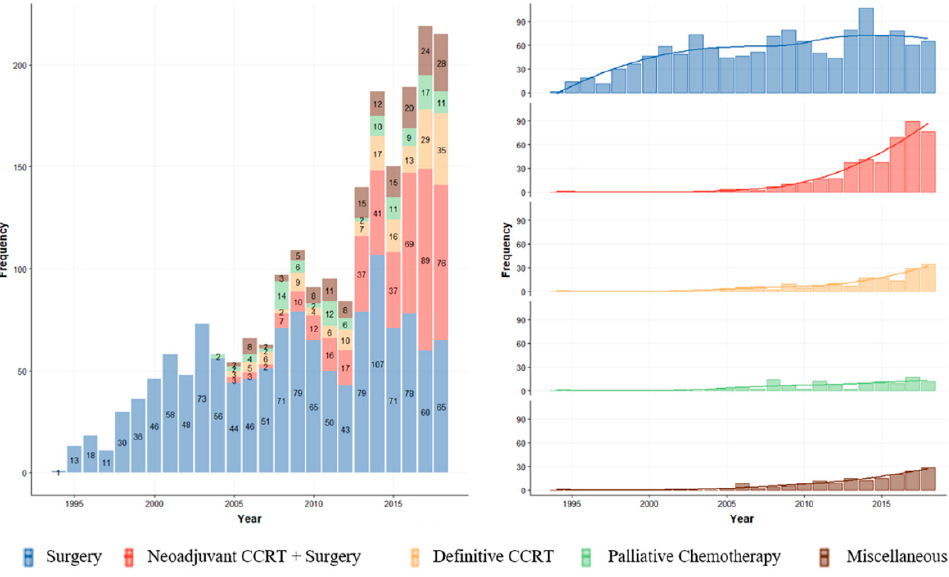
Figure 2. Annual trend of treatment for locally advanced ESCC.